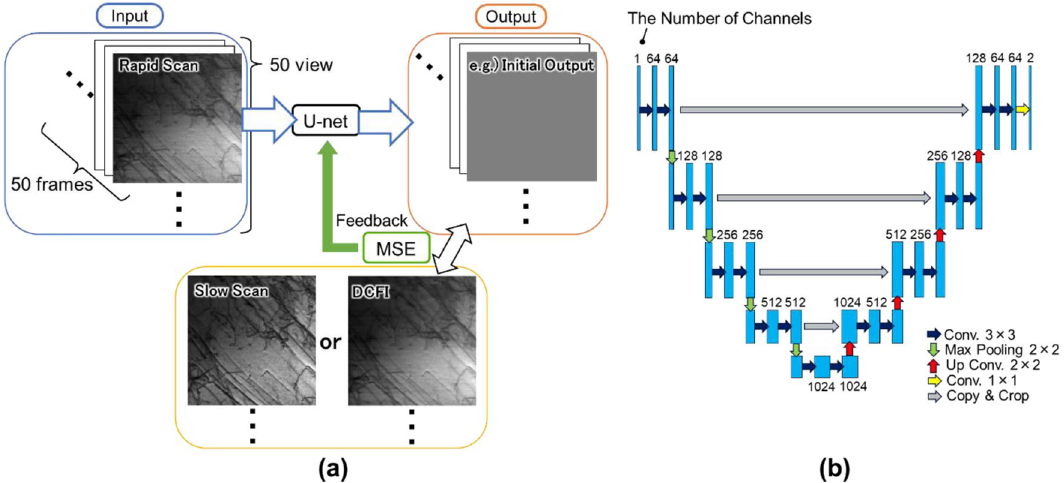
Figure 8. Summary of DL process. ( a ) Schematic drawing of DL procedure in this study. The architecture of DL algorithm is shown in ( b ) 39